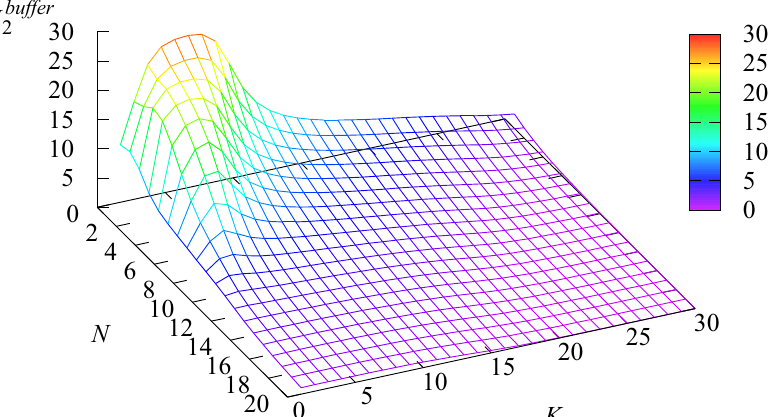
Figure 5. Dependence of the average number N buf fer parameters N and K .